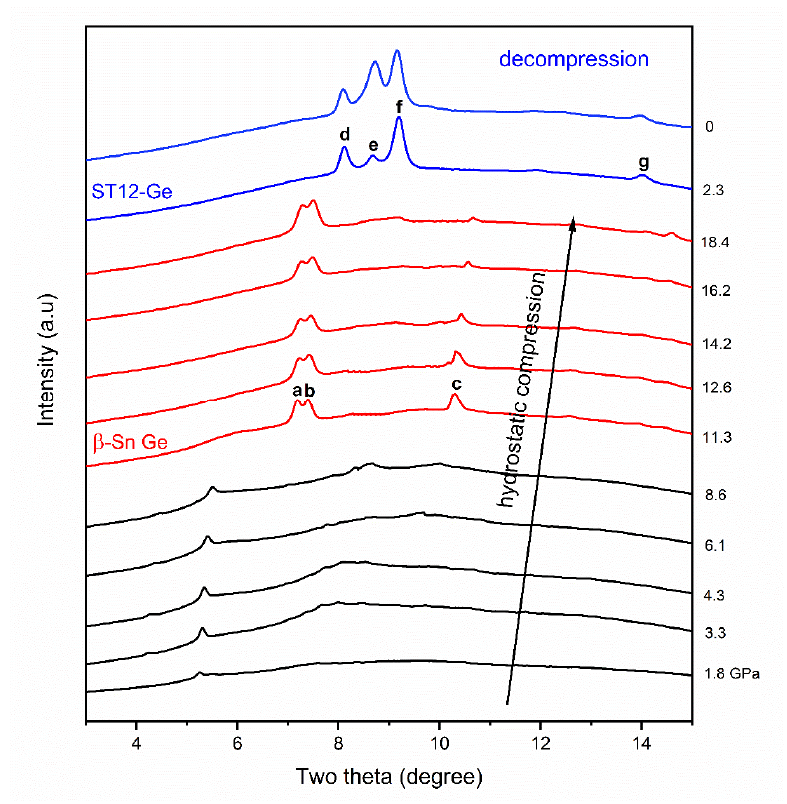
Figure 2. The XRD peaks of amorphous Ge under hydrostatic pressures. The experiment was performed with the synchrotron X-ray wavelength of 0.3100 Å at the beamline 16-BM-D, APS. Ethanol was used as a PTM for hydrostatic compression. Pressures are labeled near each diffraction line (unit: GPa). Obvious phase transitions can be seen under compression and decompression. Note that the peaks from stainless steel gasket in the XRD patterns have been masked. This sample is partially crystallized, but bumps between the two theta of 8 and 10 degrees indicate the amorphous part.